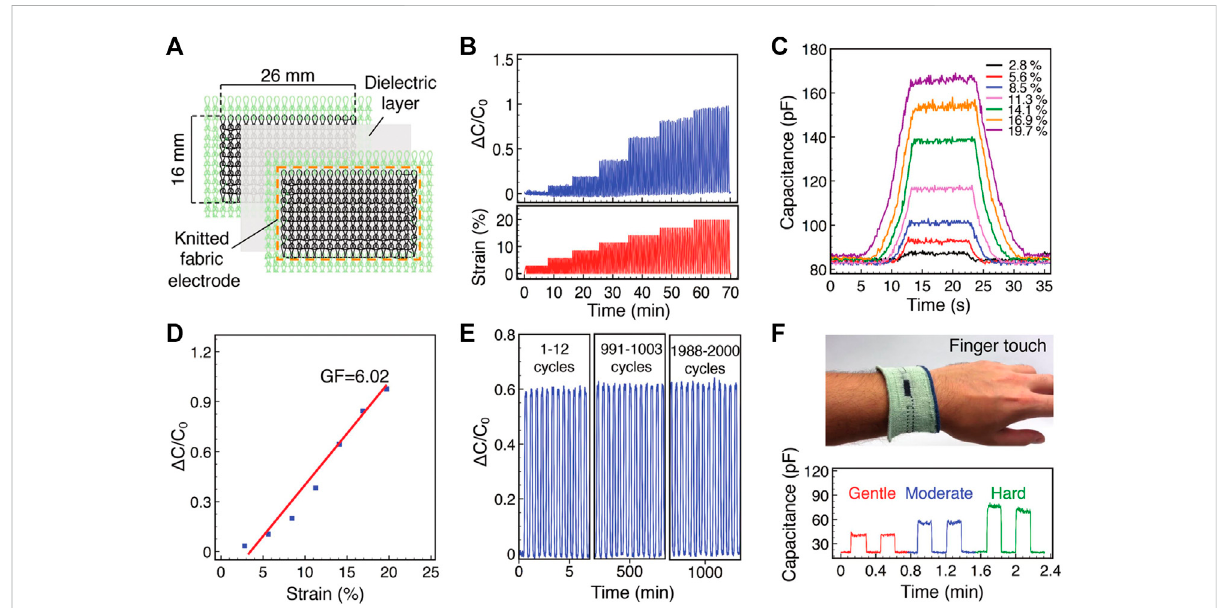
FIGURE 7 Evaluation of sensing performance of the capacitive knitted pressure sensor device. (A) Schematic representation of the capacitive pressure sensor (active area — 16 mm × 26 mm) assembled by using two knitted fabric electrodes and a dielectric layer. (B) Electromechanical behavior of the knitted sensor. The applied strain is incrementally increased from 2.8 to 19.7%. Each cyclic deformation is repeated 20 times. (C) Capacitance as a functionoftimeatdifferentcompressionstrainsrangingfrom2.8to19.7%.Theholdtimeis10 s. (D) Relativecapacitancechangesofthesensor atvarious strains. Gauge factor (GF) isderived from thelinear fi t. (E) Cyclicstability ofthe sensor based on relativecapacitance change at14.1% strain for 2000 cycles. (F) Top: Photograph of the knitted pressure sensor button (active area — 16 mm × 5 mm). Bottom: capacitance output of the sensor when a gentle, moderate, or hard pressure is applied to the device by a fi nger, Reproduced with permission from Uzun et al. (2019), ©Wiley-VCH.